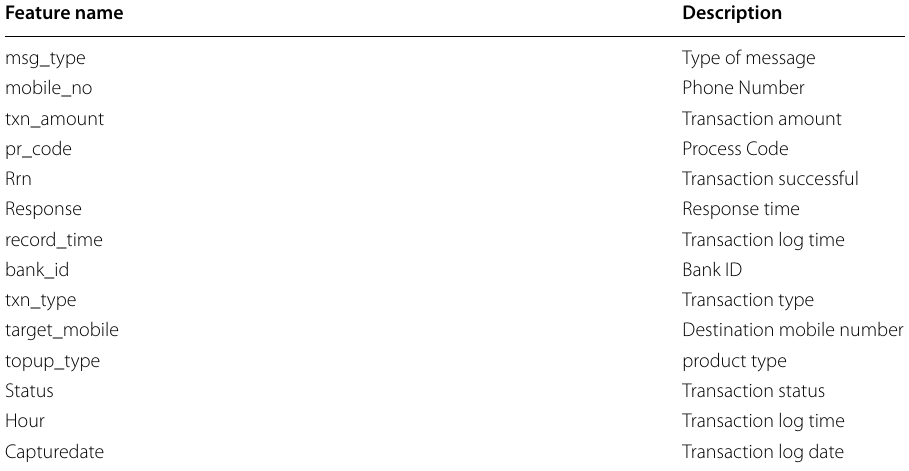
Table 6 Value added data features of iranian telecommunication